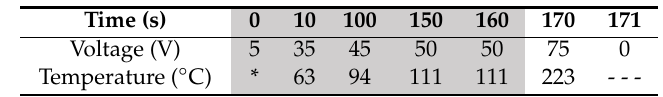
Table 1. Voltage ramp (estimated temperature ramp) applied for field FastGC / PTR-MS measurements. In grey, the ramp applied during the Q. ilex I and II measurements and the total ramp is the extended version applied for the Q. ilex III and IV